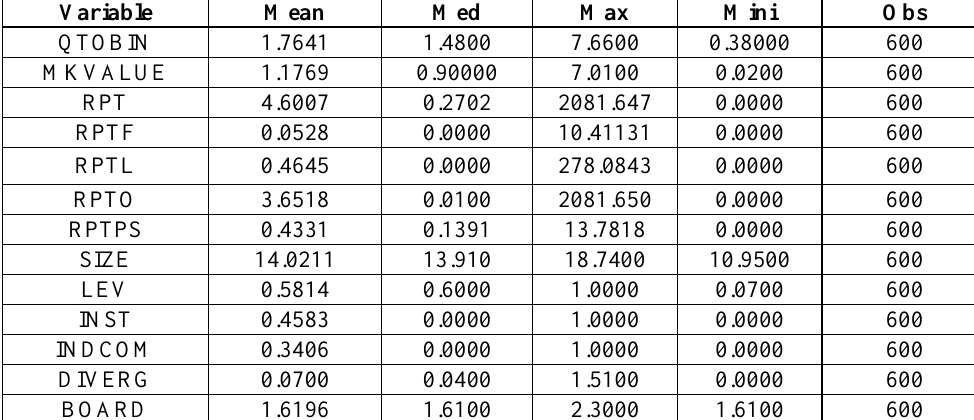
Table 2. Descriptive statistics for research